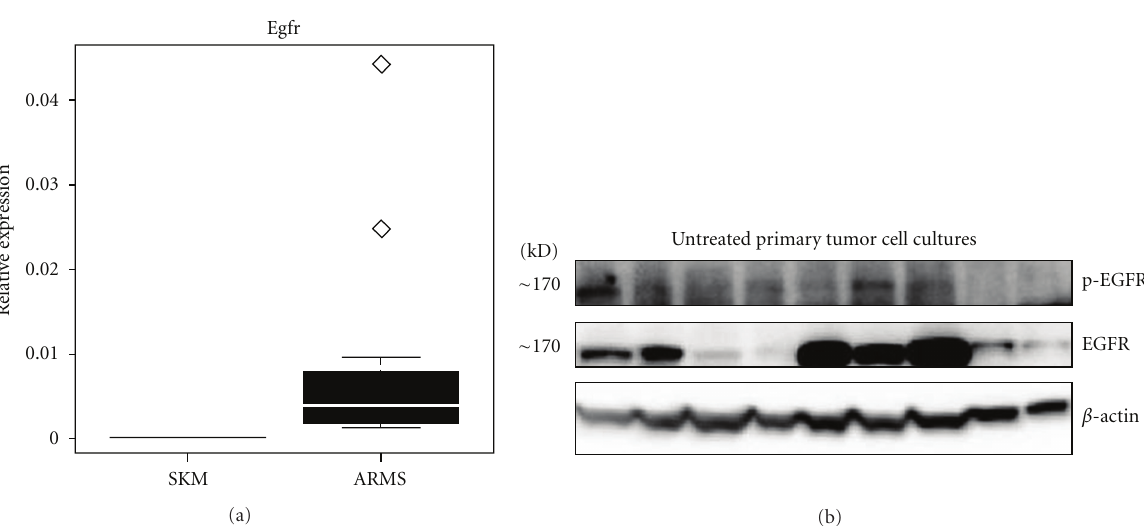
Figure 1: High expression of Egfr in mouse alveolar rhabdomyosarcoma. (a) Quantitative RT-PCR represented as a box and whisker plot showing expression of Egfr in skeletal muscle and alveolar rhabdomyosarcoma from the mouse model. (b) Western blots showing the expression and phosphorylation of Egfr in primary cell cultures established from untreated tumors from the mouse model.